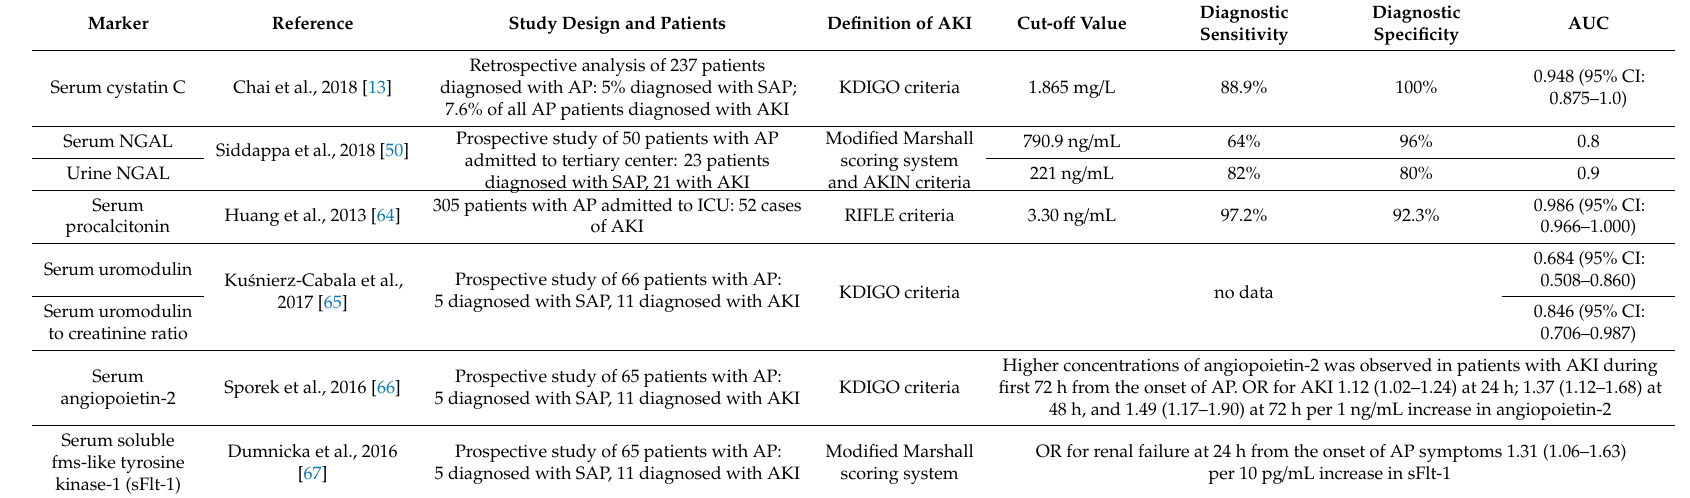
Table 3. Laboratory markers evaluated for prognosis or diagnosis of AKI in patients with